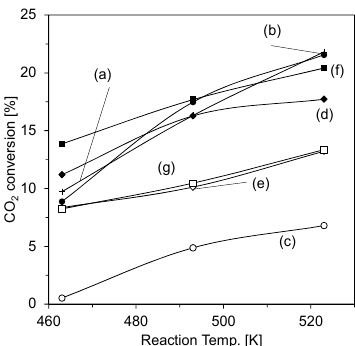
Figure 3. CO 2 conversion over pristine F04M catalyst (a) and F04M catalyst coated with silica (b,c), zirconia (d,e), and titania (f,g) using ammonia (b,d,f) and L(+)-arginine (c,e,g). Reaction conditions: 3 MPa, W/F = 5 g ¨ h ´ 1 ¨ mol ´ 1 , H 2 /CO 2 /Ar = 72/24/4 (molar